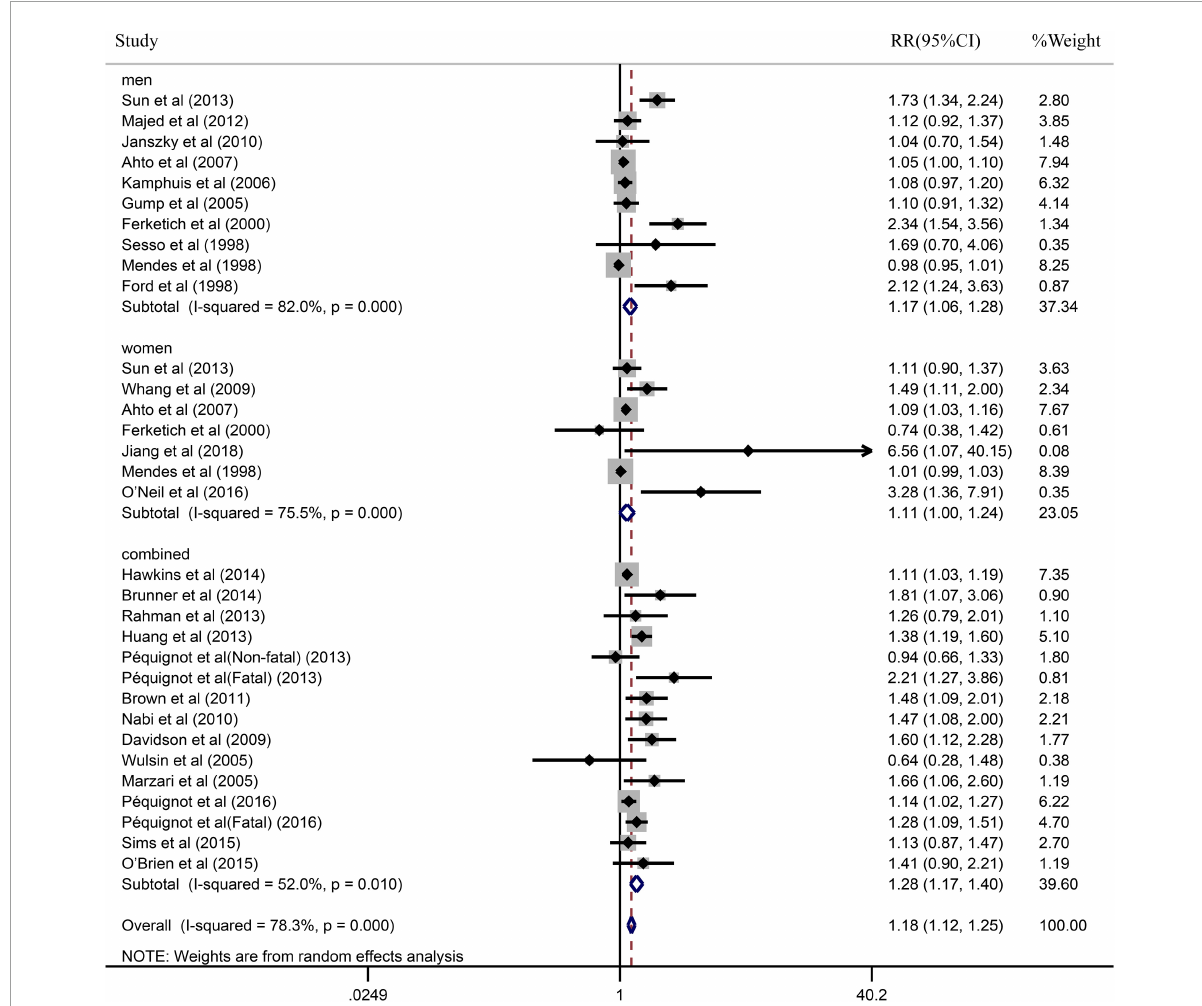
FIGURE4 Subgroup analysis with sex (men, women, or combined) presents the association between depression and the risk of coronary heart disease in a prospective cohort